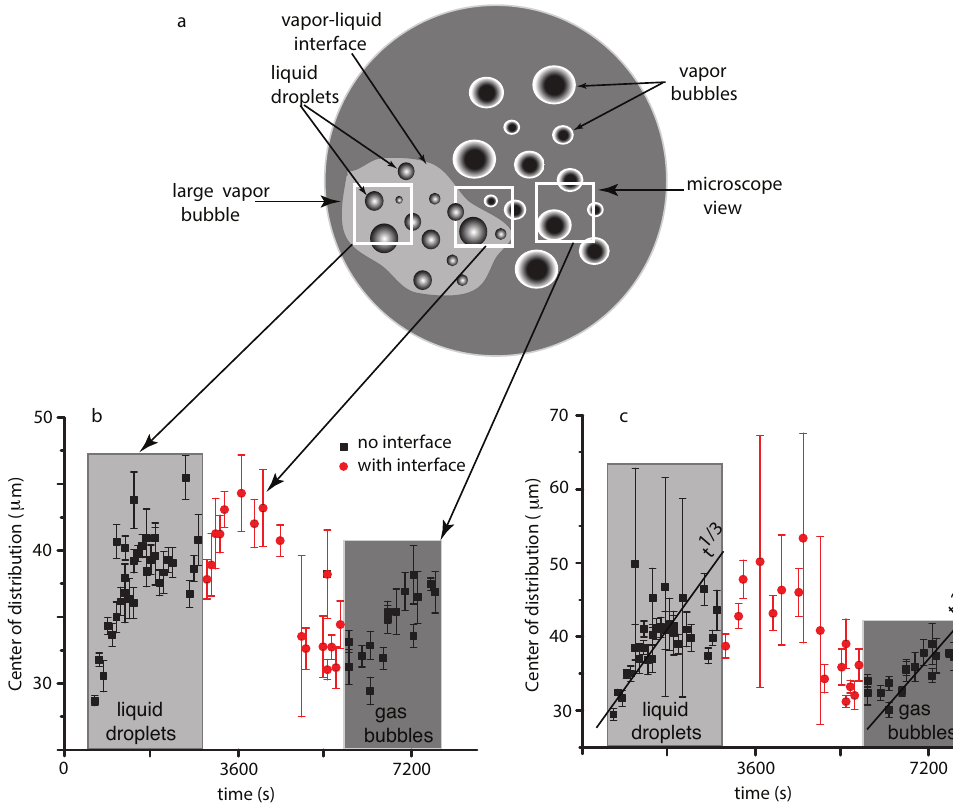
Figure 4. ( a ) a schematic representation of the sample cell unit (not at scale) containing one large vapor bubble inside the liquid matrix. The microscope view shifts over time and at early stages captures liquid droplets distributions from inside the large vapor bubble (see the leftmost white-bordered square). Later on, the microscope captures the vapor–liquid interface and a mixture of distributions (see the middle white-bordered square). At late stages, the microscope view only captures vapor bubbles embedded in the liquid matrix (see the rightmost white-bordered square). The location of the center of the Gaussian ( b ), respectively, lognormal ( c ) distributions shift over time. At first, the distribution of liquid droplets shifts towards larger radii (solid squares inside the grayed “liquid droplets” area). At some point, the interface line between the large vapor bubble and the liquid matrix drifts into focus between 2981.2 s and 5790.3 s (solid red circles) and significantly changes the trend of the distributions due to boundary effects. While the best fit is still a lognormal distribution, the center of the distribution seems to remain constant and even moves towards smaller radii. At a later time, after the vapor bubble completely receded from focus, the distribution of liquid droplets also shows an increase in its mean radius (see the grayed rectangle marked “liquid droplets”). The continuous lines in ( c ) indicate a t 1/3 evolution for liquid droplet radii and a t 1/2 evolution for vapor droplets (see [41] for data fitting details and a discussion regarding possible coalescence